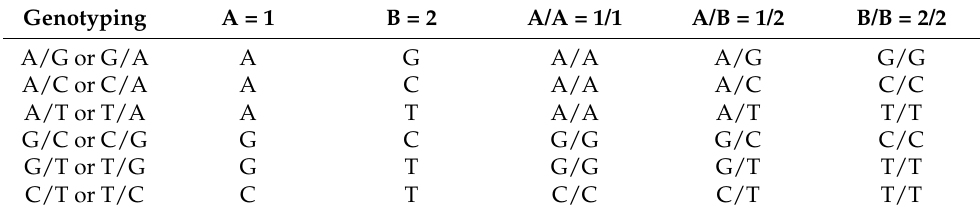
Table 1. Summarizes the standard SNP AB genotype format conversion